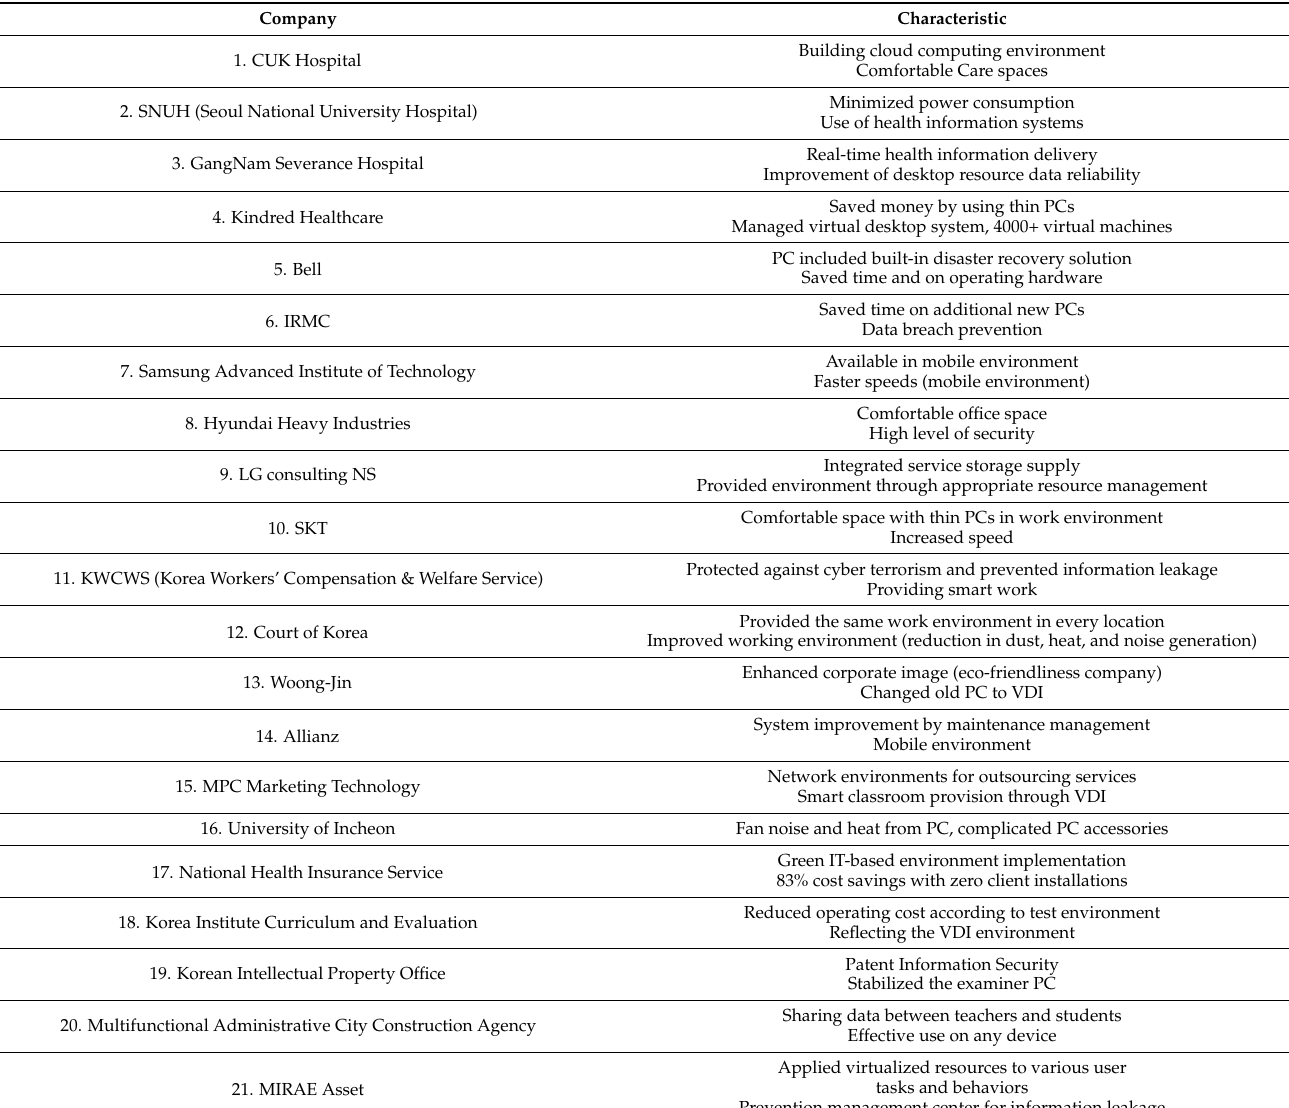
Table 1. Applications of VDI